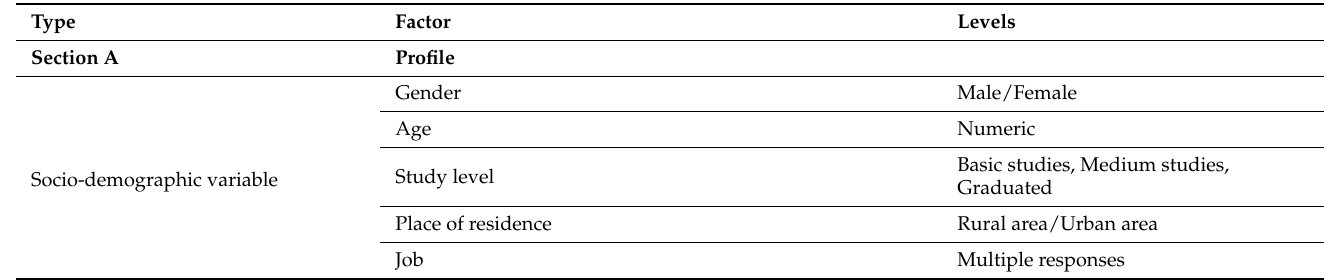
Table A1. Variables Collected in the Survey to Describe the Landscape